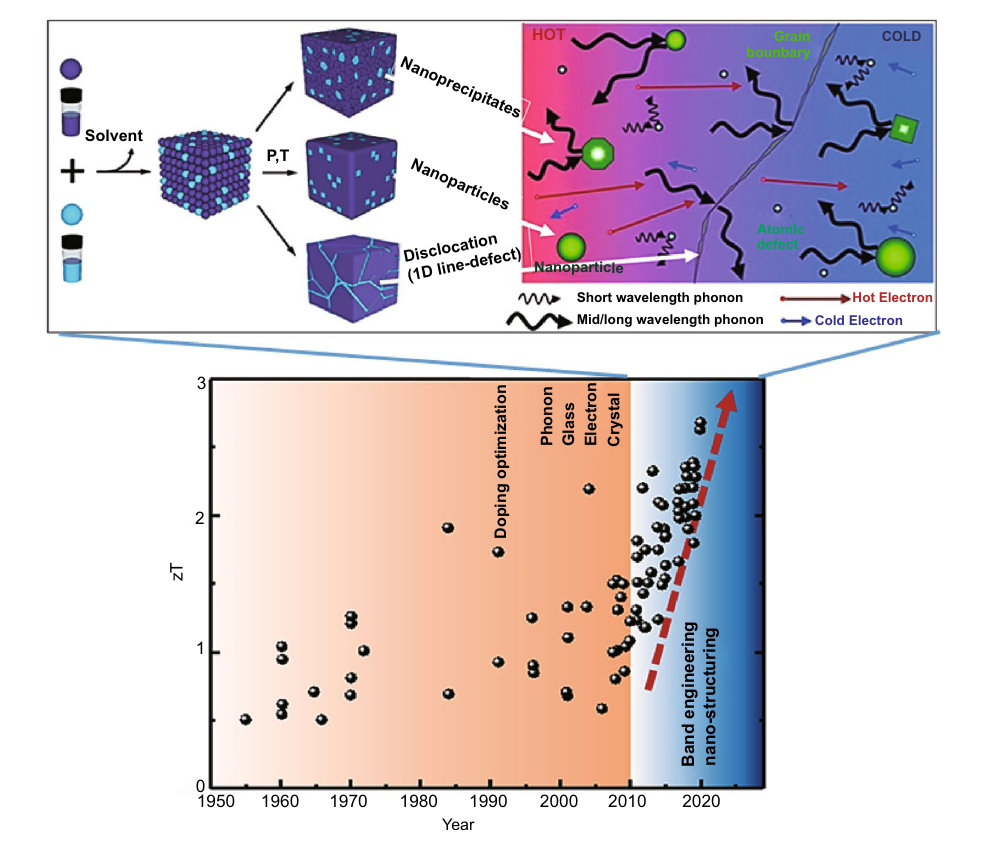
Fig. 1 Illustrations showing the bottom-up assembly to synthesize nanoscaled thermoelectric materials and the advantageous effects brought about by multi-wavelength phonon scattering due to the various shape, and size defects brought about by these bottom-up approaches. Adapted with permission from Ref. [22,